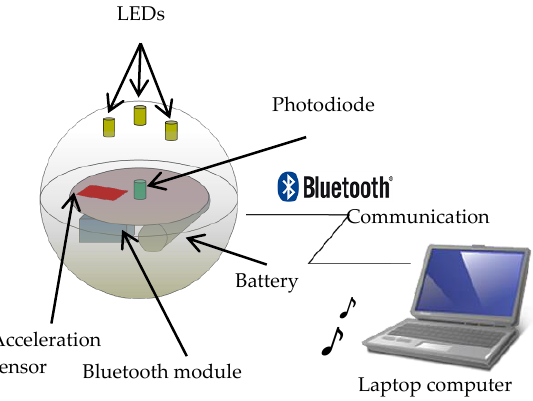
Figure 3. Overview of the proposed system. The proposed system contains acceleration, Bluetooth module, Photodiode, LEDs, and Laptop computer.